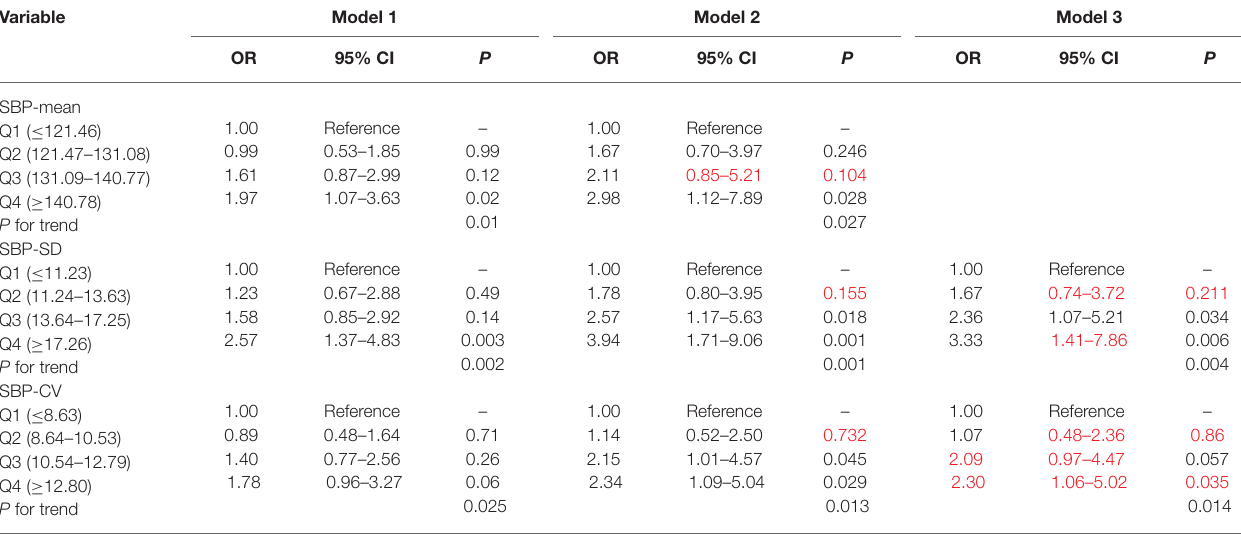
TABLE 5 | Odds ratios for unfavorable outcome according to the quartiles of mean and variability of SBP.